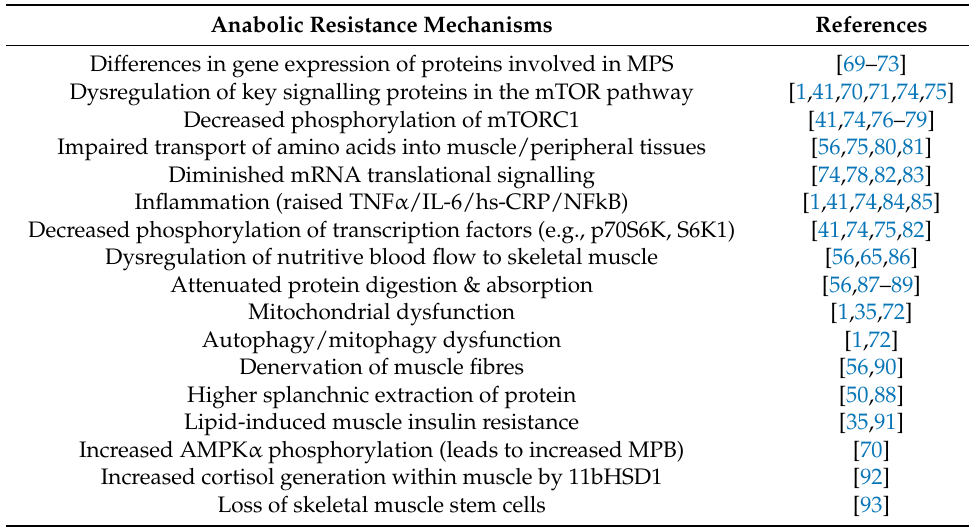
Table 2. Molecular mechanisms implicated in anabolic